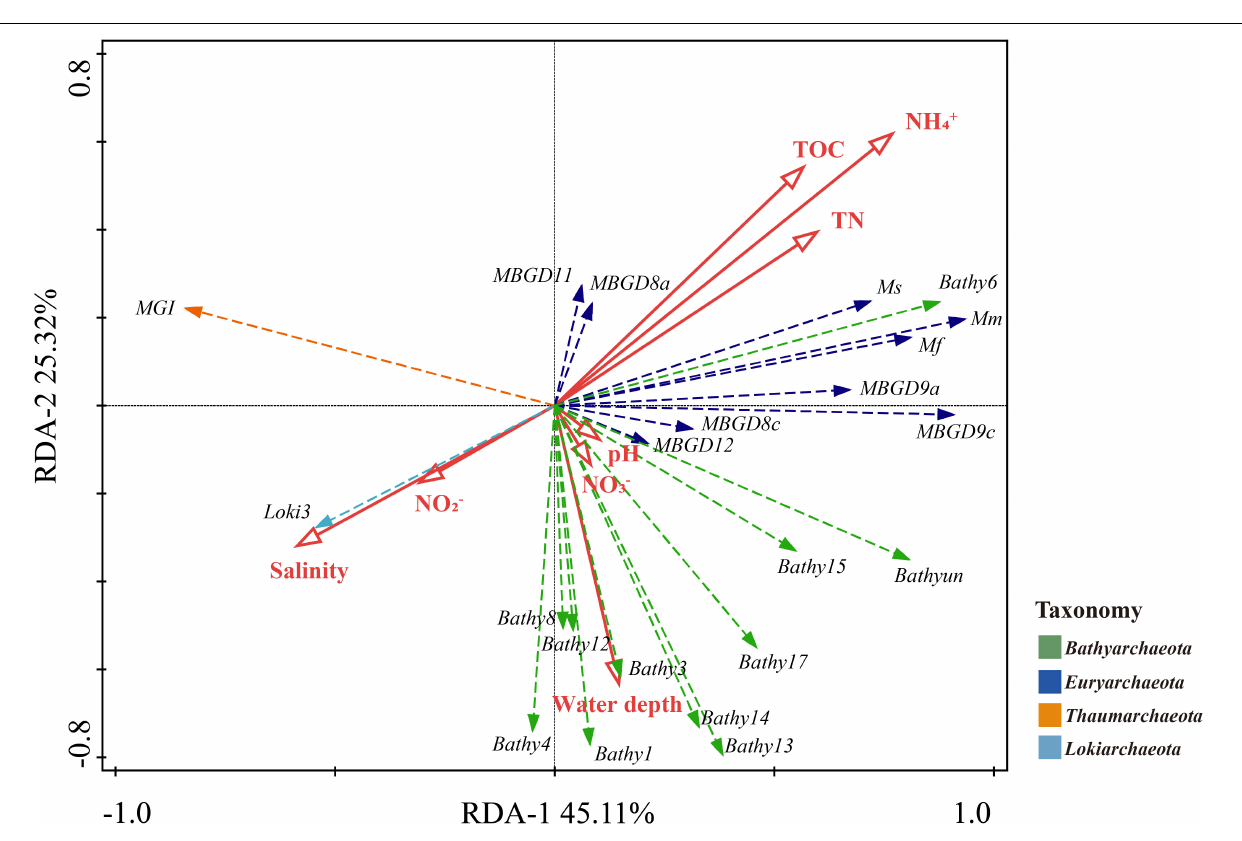
FIGURE 4 | RDA results for the relationship between the physicochemical parameters and the subgroups of Bathyarchaeota , Thaumarchaeota , Lokiarchaeota , and Thermoprofundales . Solid lines, physicochemical parameters; dashed lines, archaeal subgroups. Mm, Mf, and Ms stand for Methanomicrobiales , Methanofastidiosales, and Methanosarcinales ,